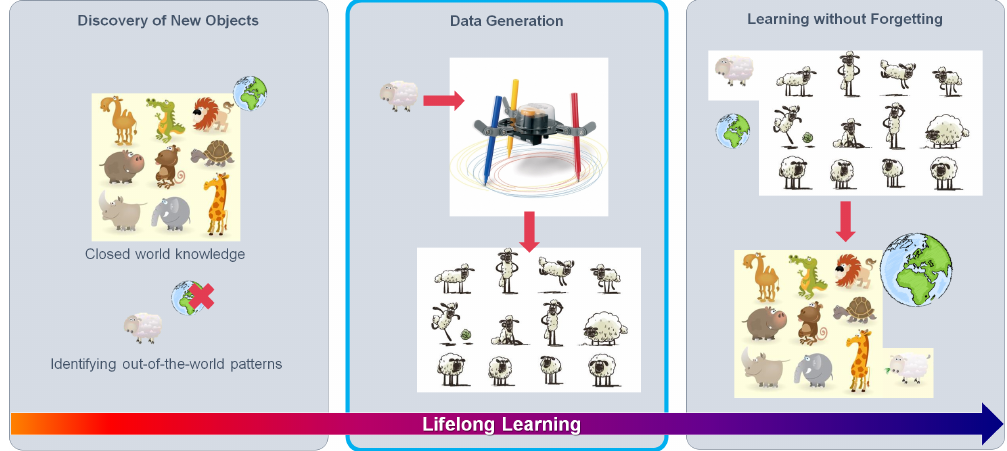
Figure 1. Lifelong learning setting. First, unknown classes are identified. Then, if we want to consider them in the future, we must collect diverse samples of these classes for posterior model retraining. Finally, we retrain the models to recognize the new classes without forgetting previous ones. In this paper, we focus on the second step, assuming that rather than collecting the samples from the real world, we generate them by using a virtual